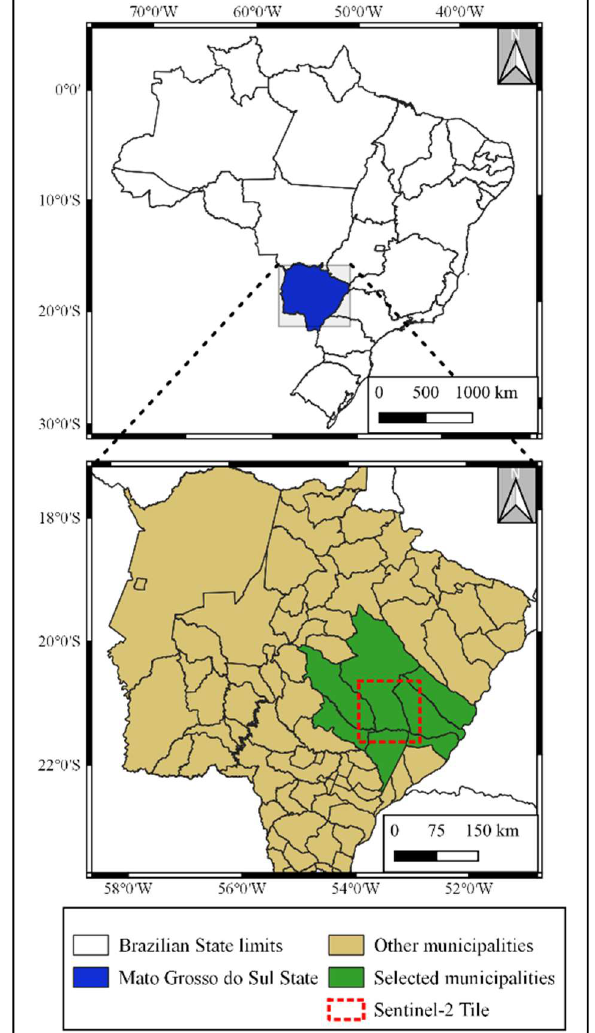
Figure 1. Study site highlighting Mato Grosso do Sul State in Brazil, the Sentinel-2 tile and also the selected municipalities for the present